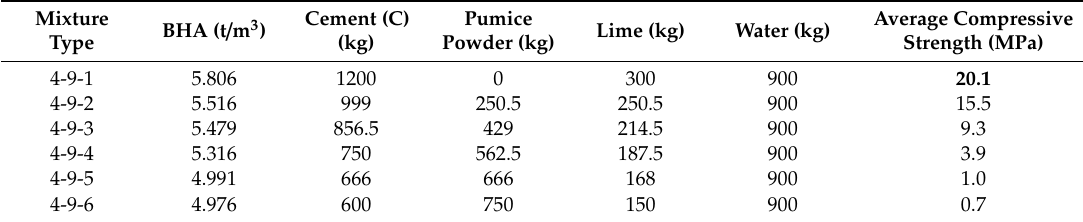
Table 33. Type-4-9 mixture quantity, weight per unit of volume and compression test results.